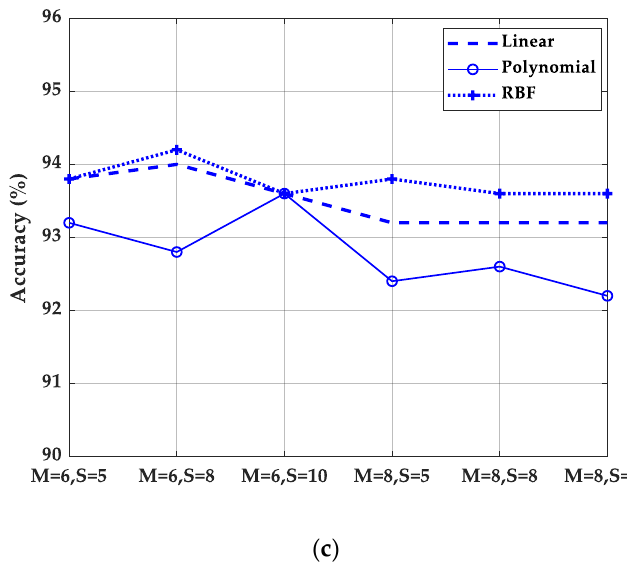
Figure 11. Results of different quantitative parameters. ( a ) Results of Kirsch mask; ( b ) results of Sobel mask; ( c ) results of Prewitt mask.